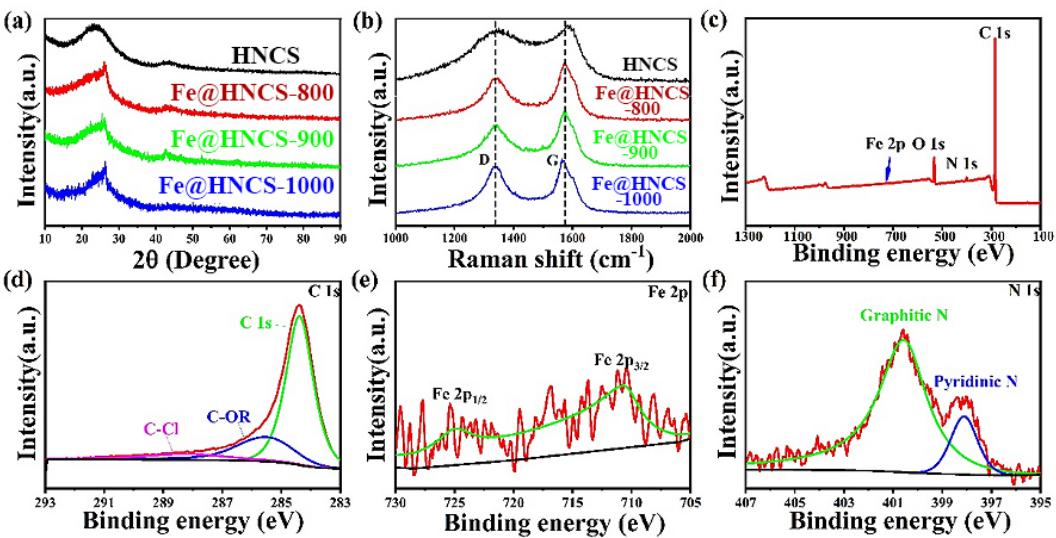
Figure 3. ( a ) X-ray diffraction (XRD) patterns and ( b ) Raman spectra of all samples; ( c ) X-ray photoelectrons spectroscopy (XPS) survey spectrum of Fe@HNCS-800; high-resolution spectra of ( d ) C 1s peak, ( e ) Fe 2p peak, and ( f ) N 1s peak.